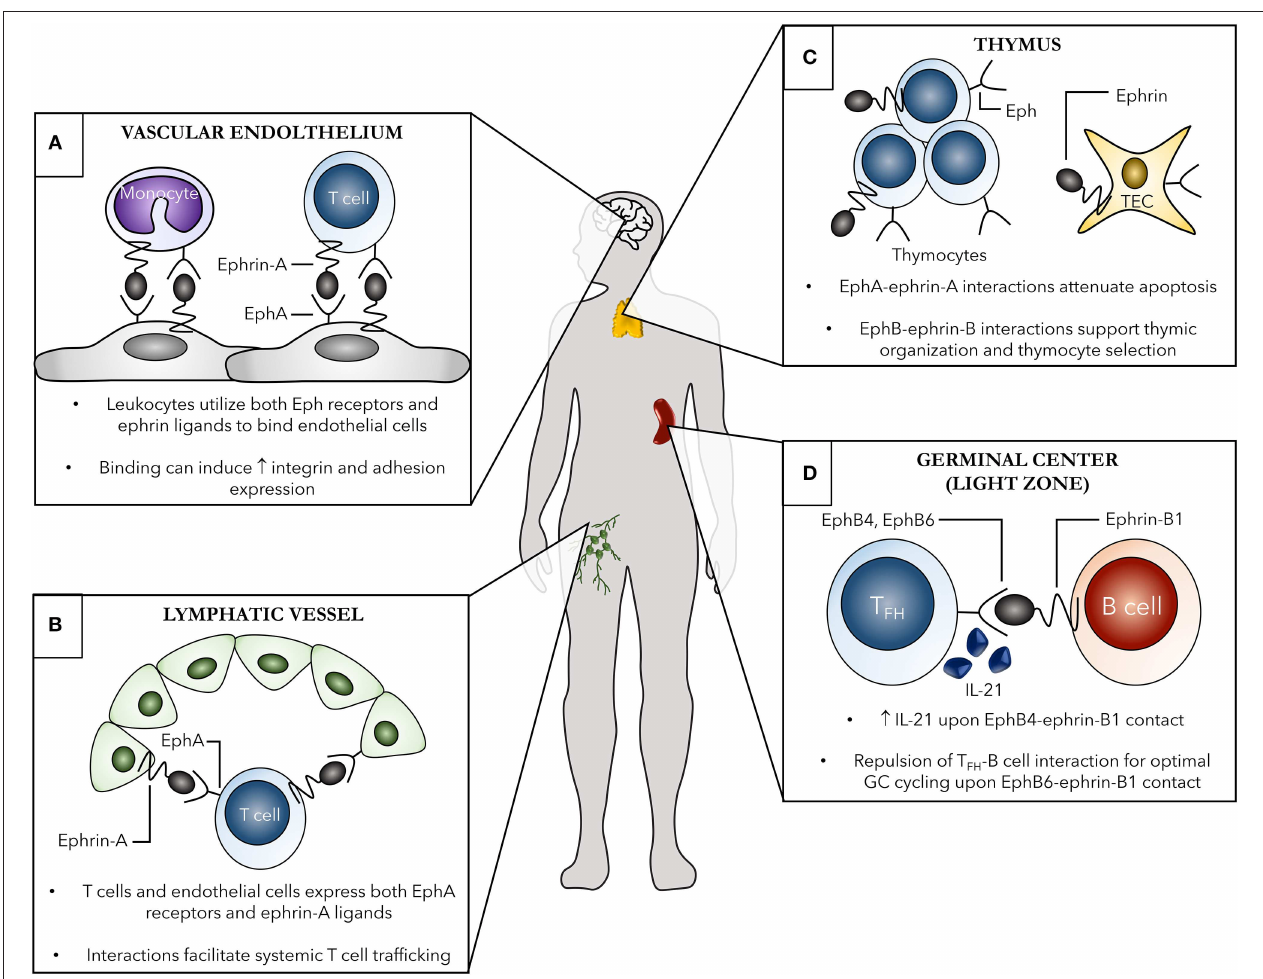
FIGURE 2 | Examples of the contribution of Eph receptors and ephrin ligands to both localized and systemic immune cell trafficking. Several systemic (A,B) and localized (C,D) roles of Eph-ephrin interactions in immunity are shown. (A) Both leukocytes, such as monocytes and T cells, and vascular endothelial cells, shown here in the brain as an example, express various Eph receptors and ephrin ligands. Eph-ephrin interactions can aid in processes such as leukocyte chemotaxis, adhesion, and transmigration of the vascular endothelium. These binding events can subsequently induce increased expression of adhesion molecules and integrins leading to enhanced cell-cell contact. (B) EphA receptors, primarily EphA2, on high endothelial venules (HEVs) of lymph nodes can interact with ephrin-A ligand-expressing T cells to facilitate trafficking between the blood and lymph. Additionally, ephrin-A1 on HEVs can bind EphA receptors on circulating peripheral T cells leading to changes in actin polymerization in the T cell and initiating subsequent chemotaxis. (C) Thymic organization as well as thymocyte development are heavily dependent on Eph-ephrin interactions. The Eph B family members are particularly important in these processes, with both single- and double-positive thymocytes as well as thymic epithelial cells (TECs) expressing several EphB receptors and ephrin-B ligands to facilitate cellular organization of the thymus and thymocyte selection. (D) EphB-ephrin-B interactions are critical for optimal germinal center interactions between B cells and T follicular helper (T FH ) cells. Ephrin-B1 marks a subpopulation of germinal center memory B cells and binding to EphB4 and EphB6 on T FH cells induces IL-21 production from the T FH cells and repulsion, respectively, both required for optimal germinal center B cell